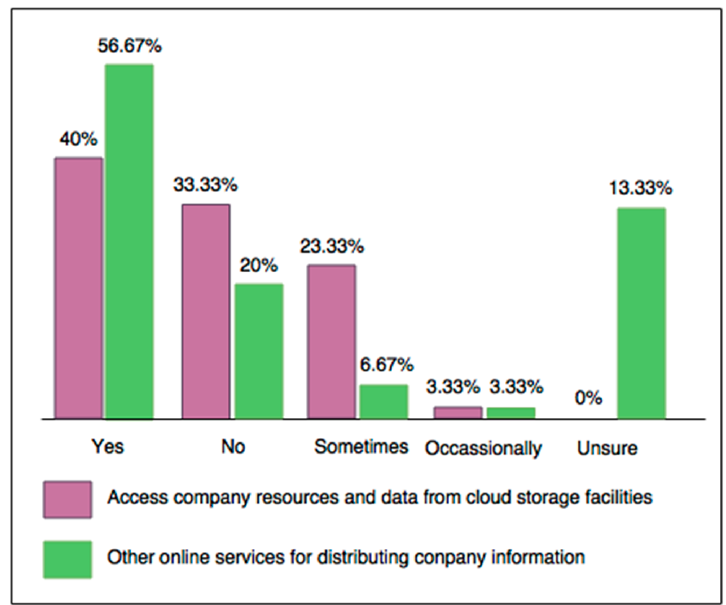
Figure 3. Data access from cloud storage and other online sharing services.